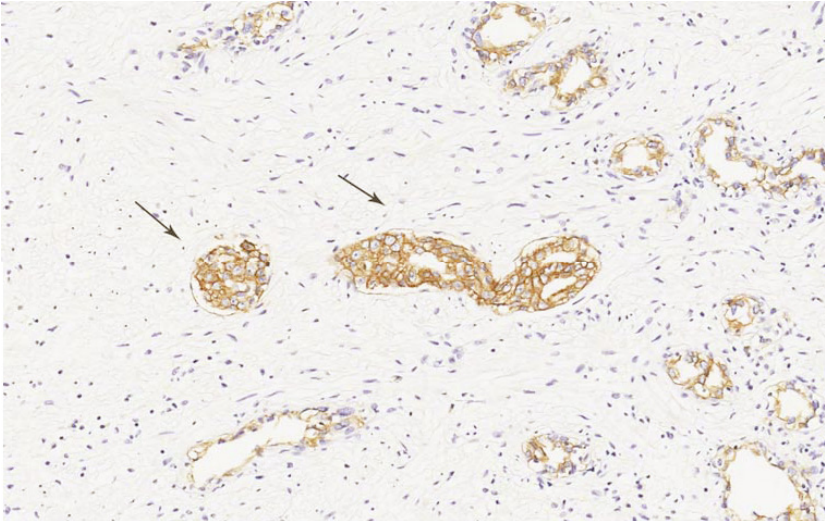
Figure 2. EpCAM staining in prostate cancer tissue. Strong brown cytoplasmic staining for EpCAM in prostate cancer cells (arrows), 400×